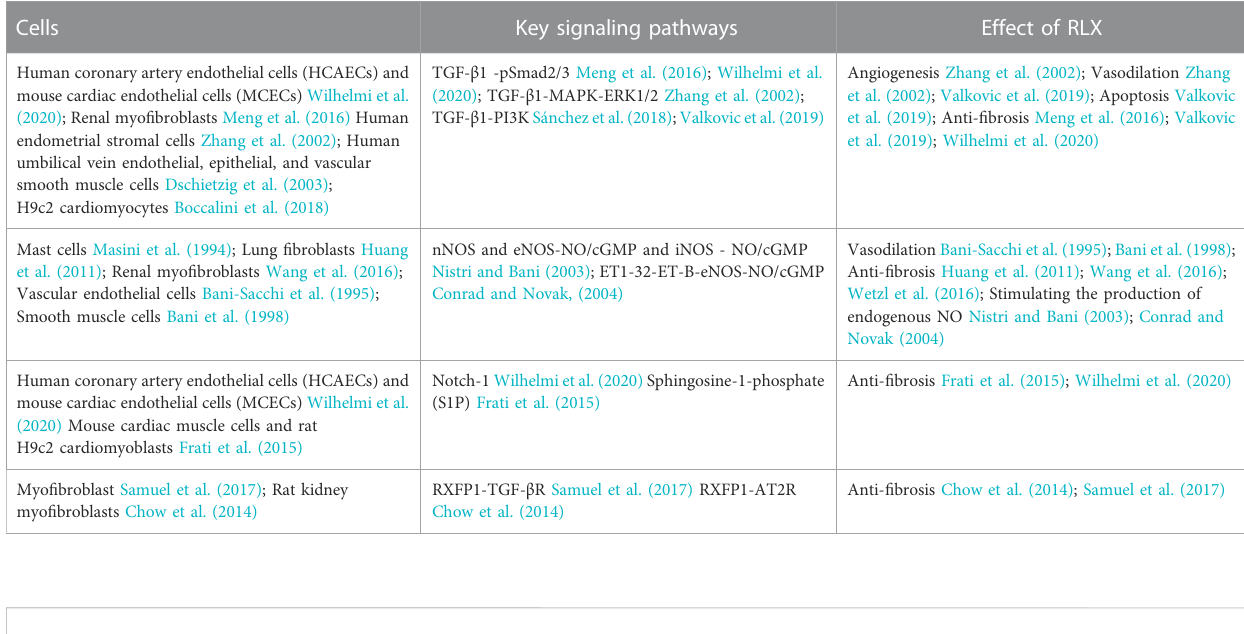
TABLE 2 Signaling pathways and effect involved in RLX. Cells Key signaling pathways